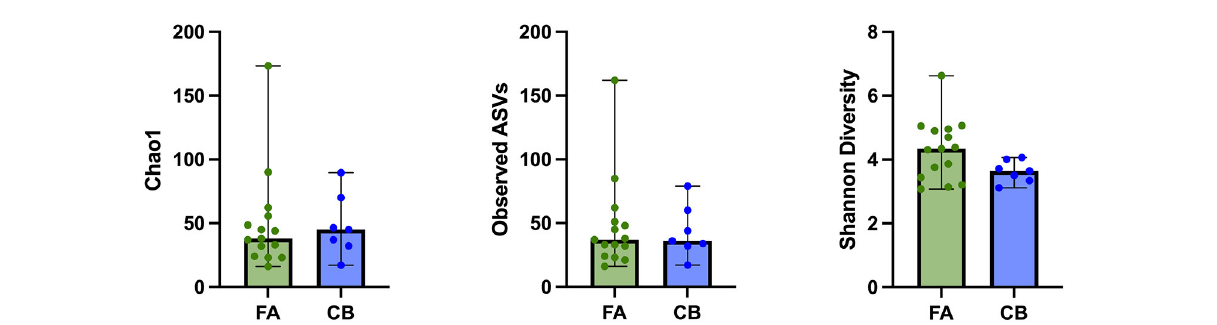
FIGURE1 Alpha diversity indices of cats with feline asthma (FA; green dots) and chronic bronchitis (CB; blue dots). Alpha Diversity indices showed no significant difference between cats in the FA and CB group. Median is represented by the upper limit of the colored boxes, range is represented by the upper and lower thin